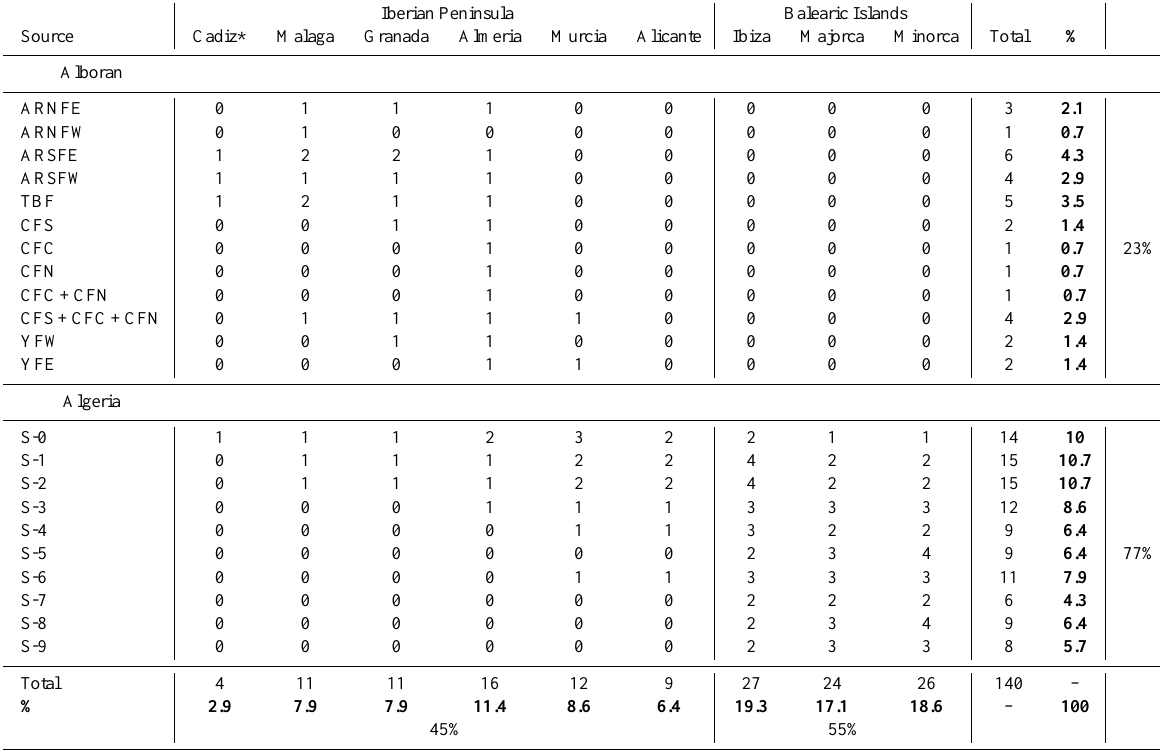
Table 2. Threat level of the considered sources on the Spanish coasts of the Iberian Peninsula and Balearic Islands depending on the Maximum Wave Elevation (MWE) at the isobath of 10m. The numbers refer to the level of threat: 0–No threat (MWE < 0.05m); 1– Marine threat (0.05m < MWE < 0.5m); 2–Land threat (0.5m < MWE < 1m); 3–Severe Land threat (1m < MWE < 2m); 4–Severe Land threat with maximum wave elevations over 2m (MWE > 2m). The “total” column shows the sum of the threat levels on the different provinces and islands. The % is the normalized threat. See text for further